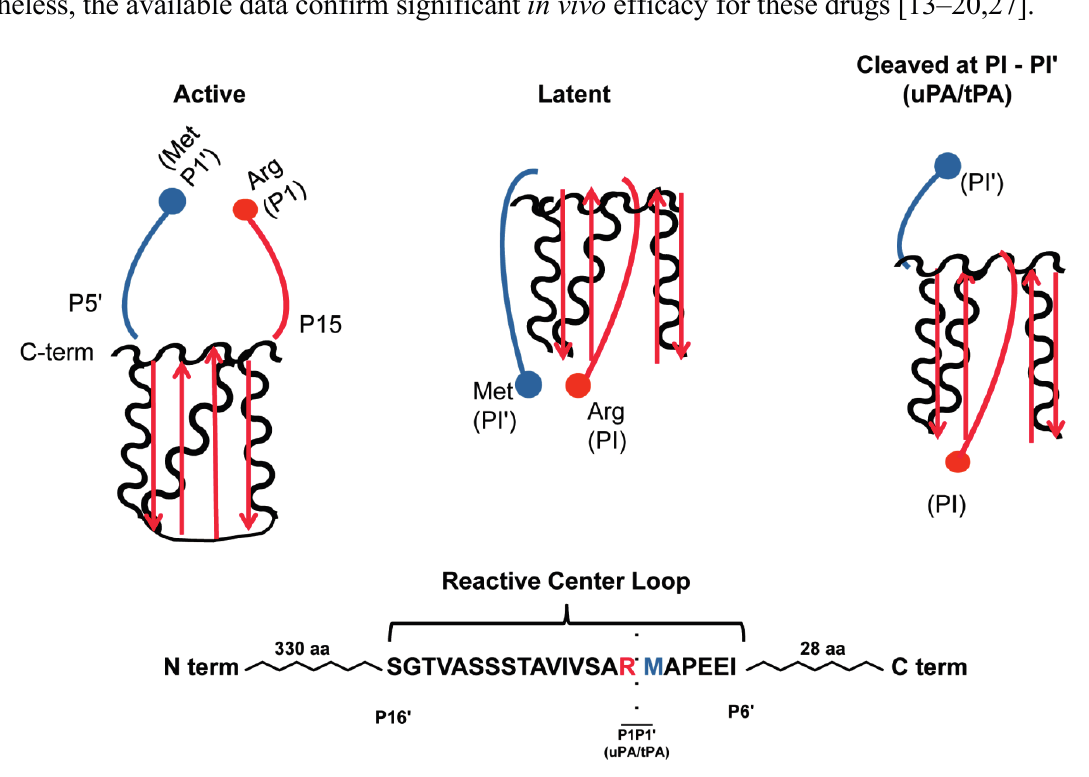
Figure 1. PAI-1 Conformations. In the active conformation, the C-terminal PAI-1 reactive center-loop is in the strained position. Conversion into the latent conformation, implies the N-terminal side of the reactive center loop is inserted into β -sheet A (depicted in red) and forms the new β -strand 4A, and the formation of an extended loop by the C-terminal end of the reactive center loop and disruption of the P1-P1' peptide and does not inhibit proteases. Physiologically, this conformation is reversible, suggesting that PAI-1 can be “stored away” in the latent conformation, but reactivated under circumstances requiring antiproteolysis. When PAI-1 is in the substrate form, proteases are able to cleave PAI-1 at the scissile bond between the P1 (Arg 346 ; red ball) and P1' (Met 347 ; blue ball) residues. The cleaved N-terminal end of the reactive center loops inserts inserted into β -sheet A (depicted in red) and forms the new β -strand 4A, and again distorts the P1-P1' peptide. This conformation, unlike the latent, is not reversible and is permanently unable to inhibit